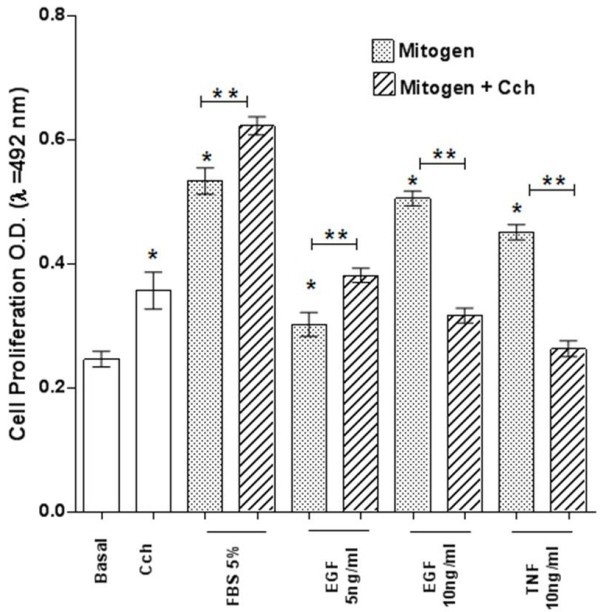
Rat ASMC proliferation in response to Cch and mitogens. ASMC (1 × 103 cells/well) were cultured in 96 wells plates at 37°C/5% CO2 with DMEM/F-12 medium (basal), Cch 10-3 M, 5%FBS, EGF 5 and 10 ng/mL, and TNF-α 10 ng/mL during 24 hrs. Cell proliferation was determined using a colorimetric method (MTS-PMS), measuring O.D at λ = 492 nm. Data is the mean ± ES of n = 6 experiments for triplicate. Each mitogen proliferation responses vs basal was significant (*) p < 0.05. Moreover, significant differences (**) p < 0.05 between mitogen vs mitogen plus Cch condition were found.